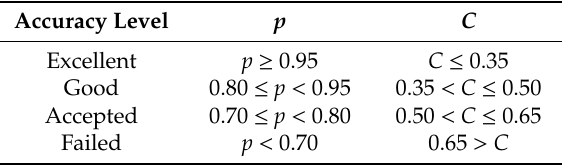
Table 2. Accuracy levels of the grey model (GM) (1, 1) [99,100].